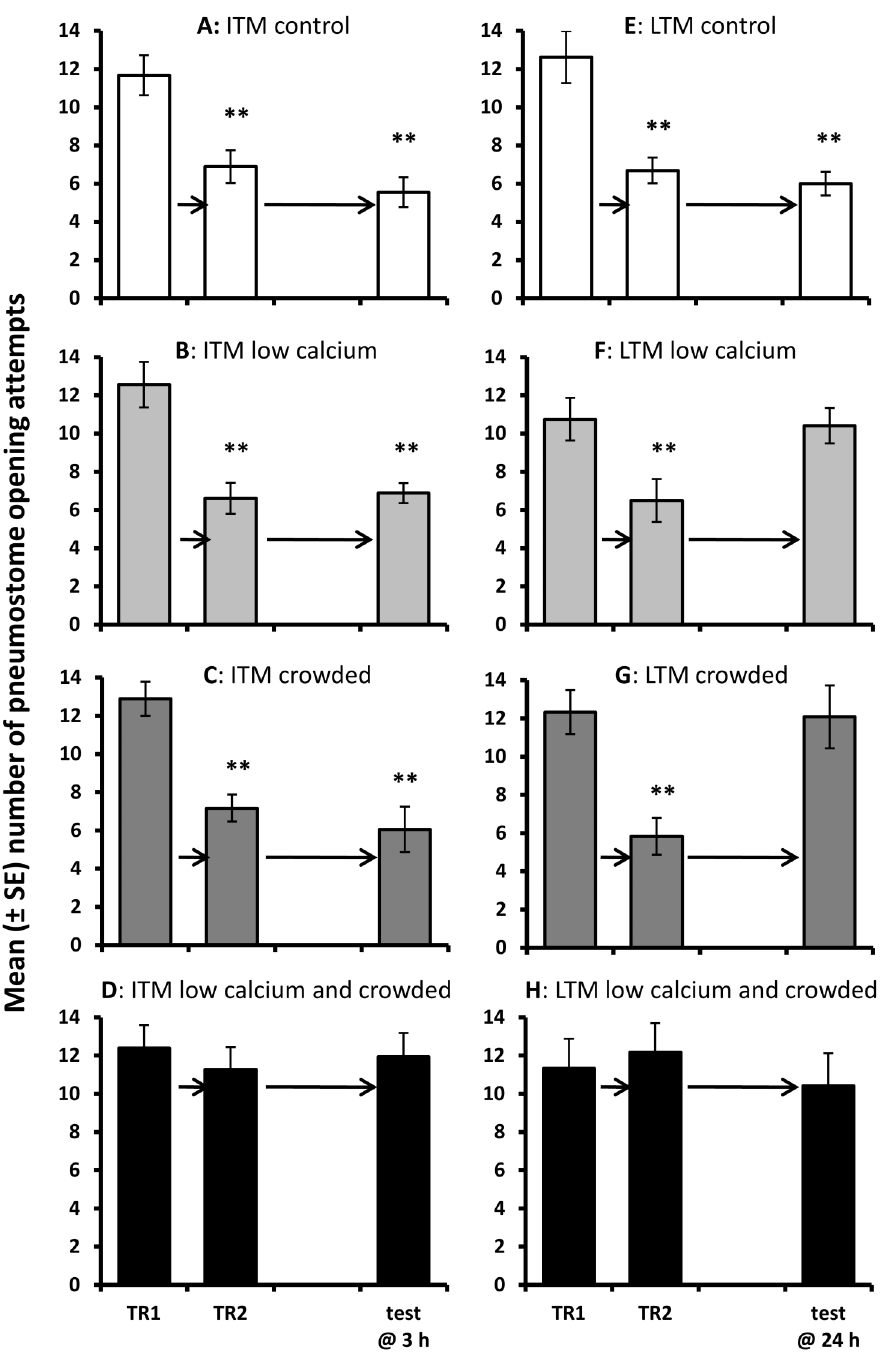
Figure 4. Behavioural assessment of intermediate-term and long-term memory. Mean ( 6 SEM) number of pneumostome opening attempts during training (TR1 and TR2) and the test for intermediate-term memory 3 h following training (A to D: test @ 3 h) or long-term memory 24 h following training (E to H: test @ 24 h). Lymnaea were exposed to:control conditions (white bars: A: N=18; E: N=13); low calcium availability (pale grey bars: B: N=18; F: N=12); crowding (dark grey bars: C: N=18; G: N=12) or a combination of low calcium availability and crowded conditions (black bars: D: N=18; H: N=12). ** = significant difference between the first training session (TR1) and second training session (TR2) or the memory test (P , 0.01, paired t-test).